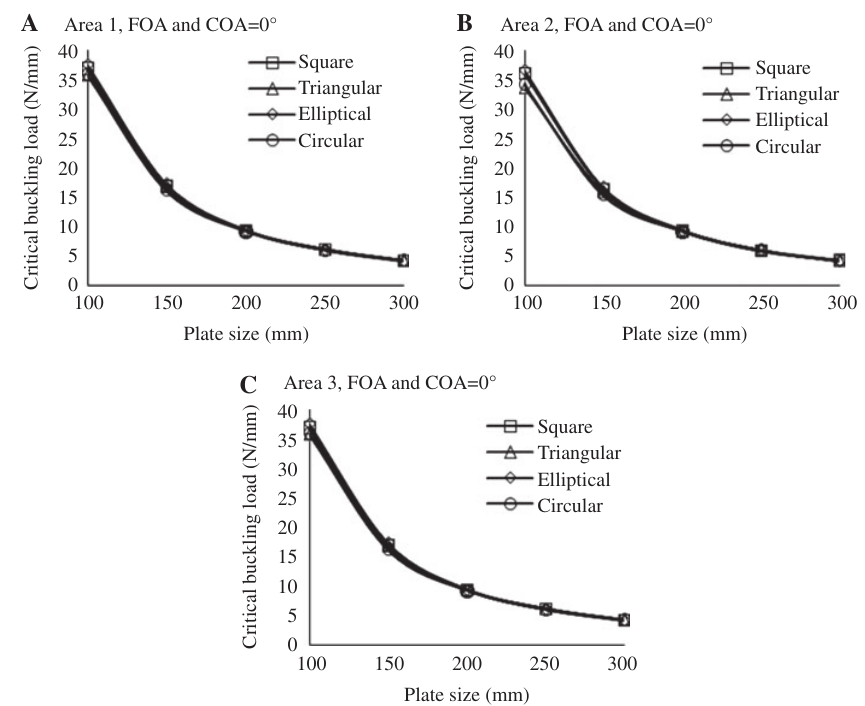
Figure 8 The effects of plate size on buckling load of the composite plates, FOA and COA = 0 ° and cutout area (A) 1, (B) 2, (C) 3 used.